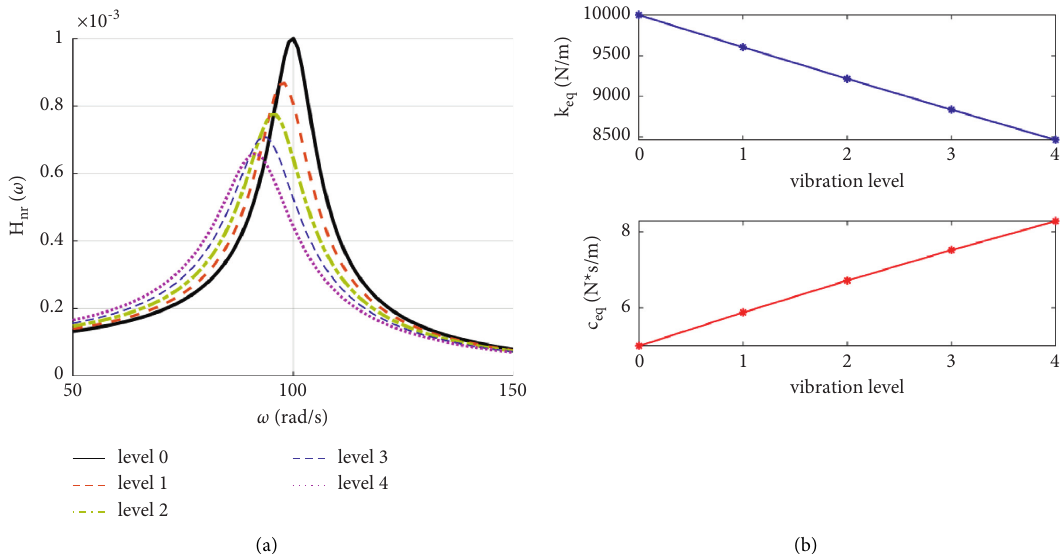
Figure 2: Equivalent linearization of nonlinear spring-damping element with different vibration magnitudes. (a) FRFs and (b) equivalent stiffness and equivalent